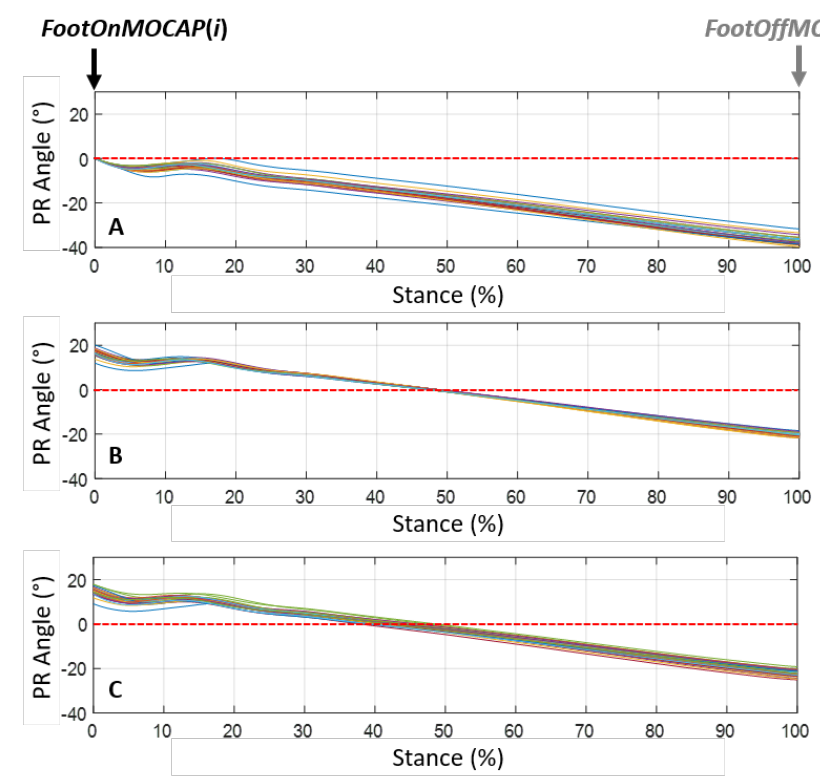
Figure 6. Protraction/retraction angles (PR) normalized by the stance phase obtained by calculating the cumulative trapezoidal integral without resetting, named AngleCanonIMU_ temps ( i ) ( A ), with resetting at the index 50% Stance( i ), named AngleCanonIMU_ 50%S ( i ) ( B ) and with resetting to the index minWithersIMU( i ), named AngleCanonIMU_ minW ( i ) ( C ) of the gyroscope signal on the Y axis on the 26 strides recorded during a trial at a 4 m/s trot of one horse ( i ranging from 1 to 26).